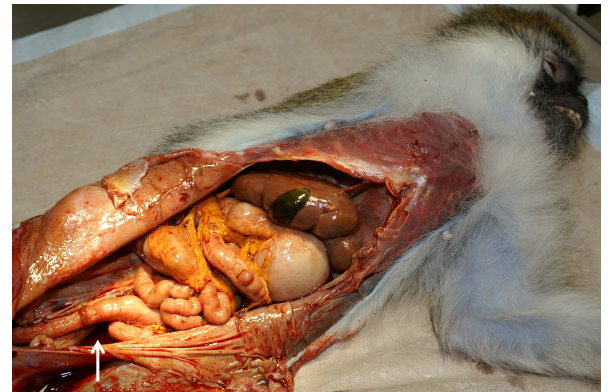
Figure 1. Opened abdominal cavity of an African green monkey with a reactive mesothelial hyperplasia: tan discoloration of the ab- dominal organs, rough appearance of the peritoneum, and remains of the abdominal fluid (arrow).